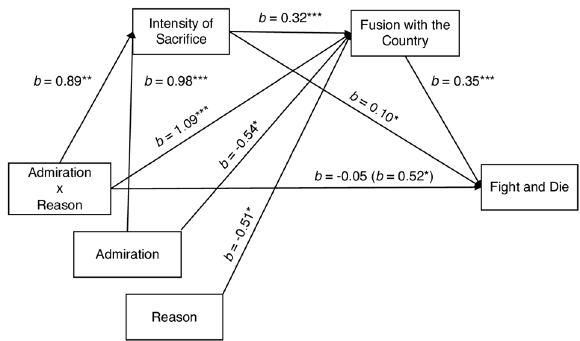
Fig. 5 Linear mediation model in Study 4 ( N = 241). In the personal sacri fi ce conditions, admiration in fl uenced willingness to fi ght and die via